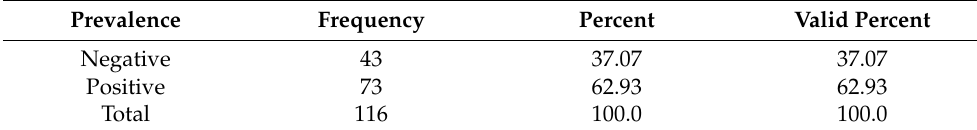
Table 4. Prevalence of mecA gene in S. aureus isolates.